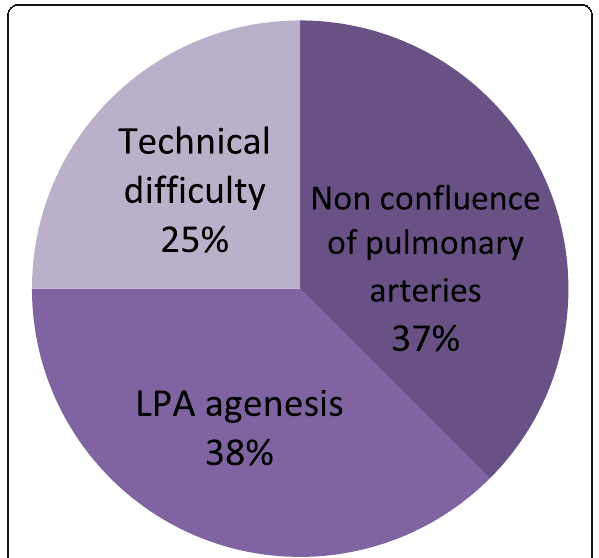
Fig. 3 Causes of non-visualization of the pulmonary arterial tree by echocardiography as a